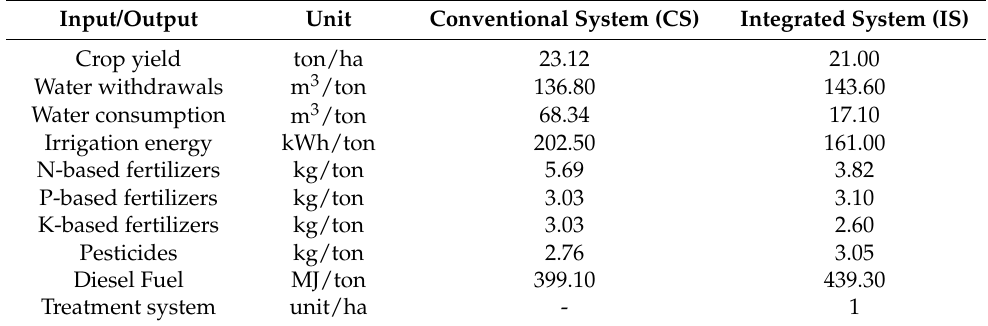
Table 1. Key primary data for table grape production under conventional (groundwater) and integrated (groundwater + treated wastewater)